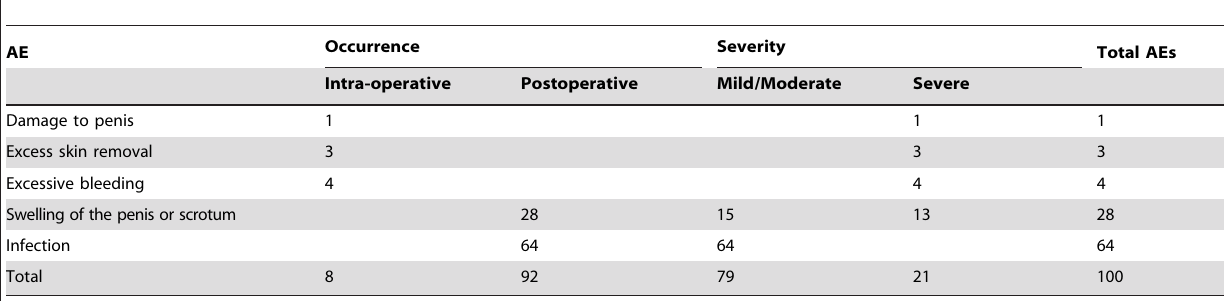
Table 2. Adverse events during the